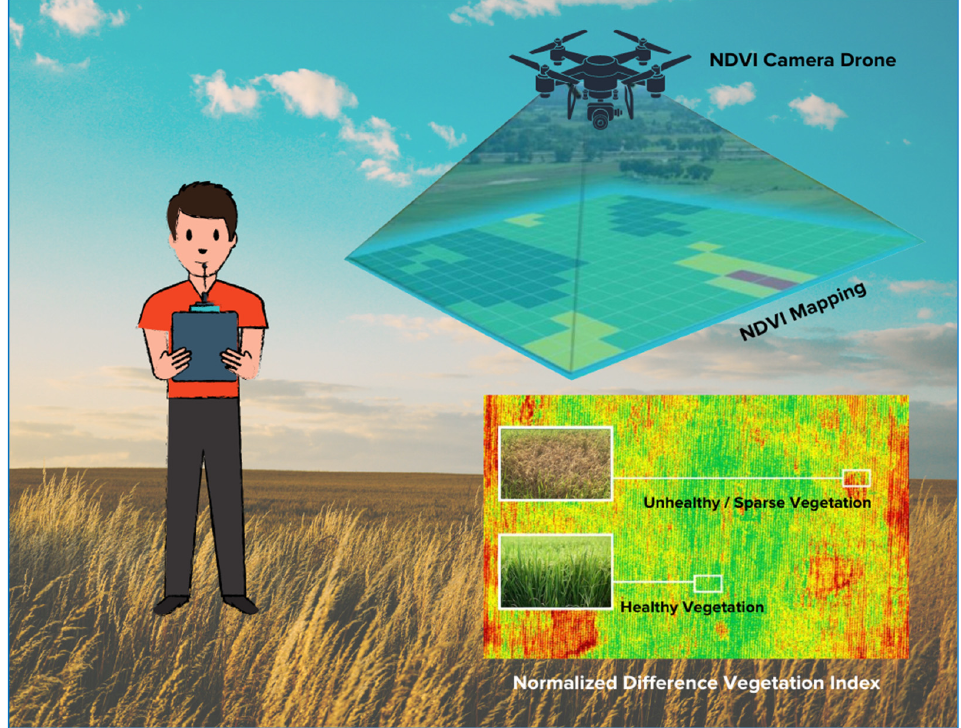
Figure 9. Smart disease management by using normalized difference vegetation index (NDVI), drone and imaging techniques. Modified figure where the drone mapping image on the top right was obtained from: https://www.futurefarming.com/tech-in-focus/pain-points-of-nitrogen-applications-how-drone-data-helps/, accessed on 14 June 2022. Table 4. Methods and precision percentage for detecting and classifying diseases in smart agriculture.